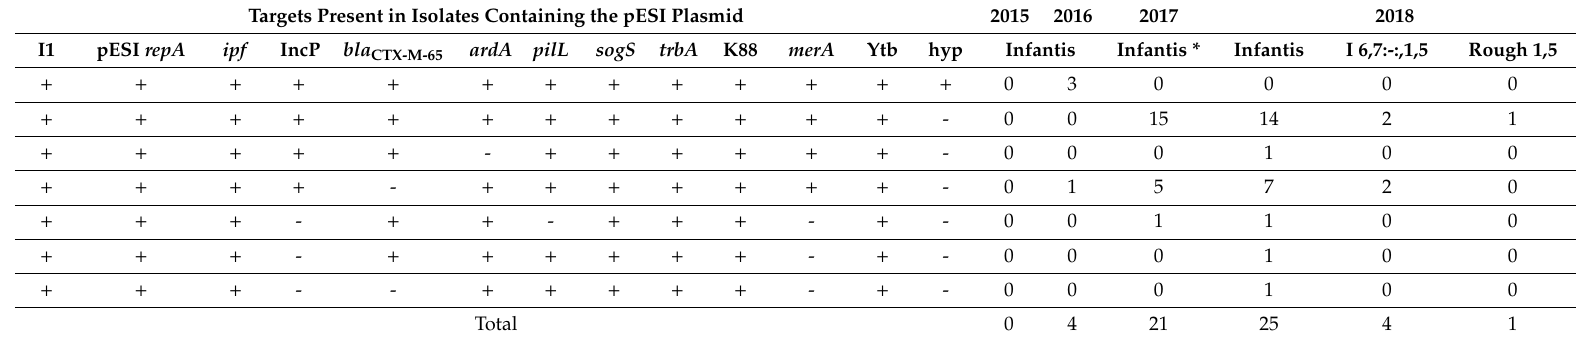
Table 3. pESI target profiles of the Centers for Disease Control and Prevention National Antimicrobial Resistance Monitoring System isolates. Plus indicates present, minus indicates